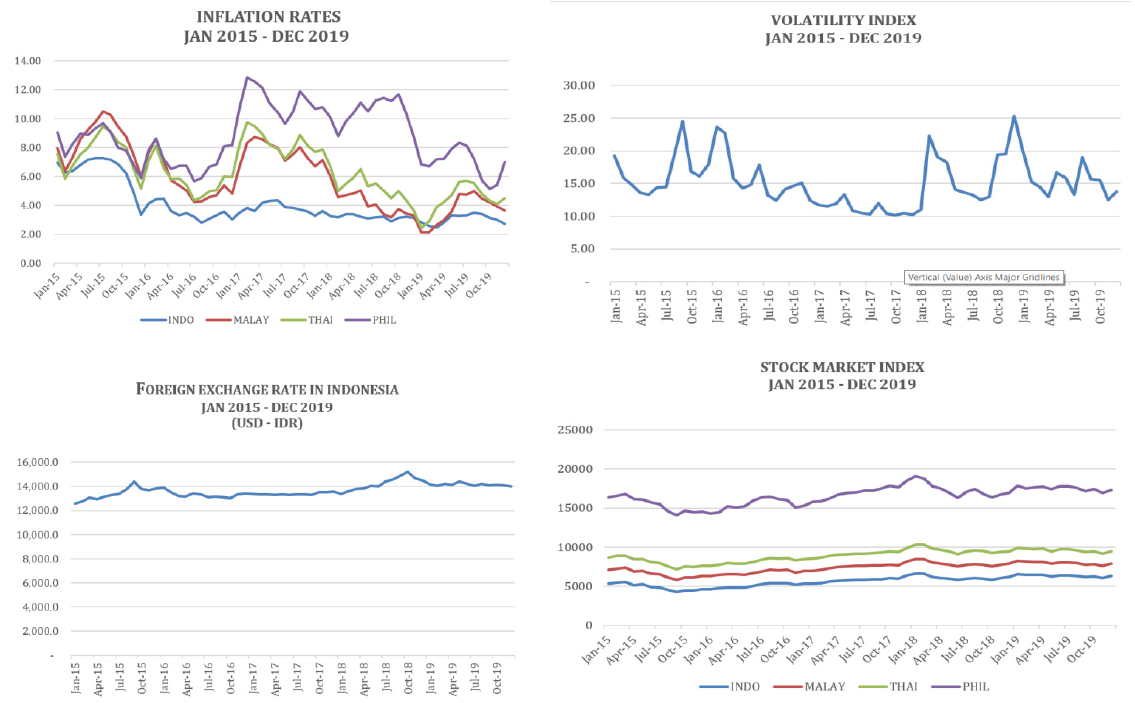
Figure A1. Graph of inflation rates, foreign exchange rates, volatility index, credit default swap, and stock market index in Indonesia, Malaysia, Thailand, and the Philippines from January 2015 to December 2019